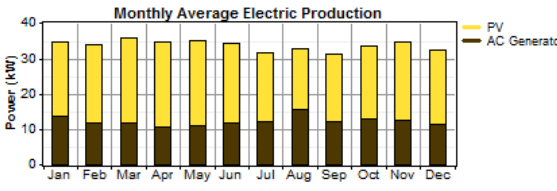
Figure 14: Monthly Average Electric Production for Maiduguri